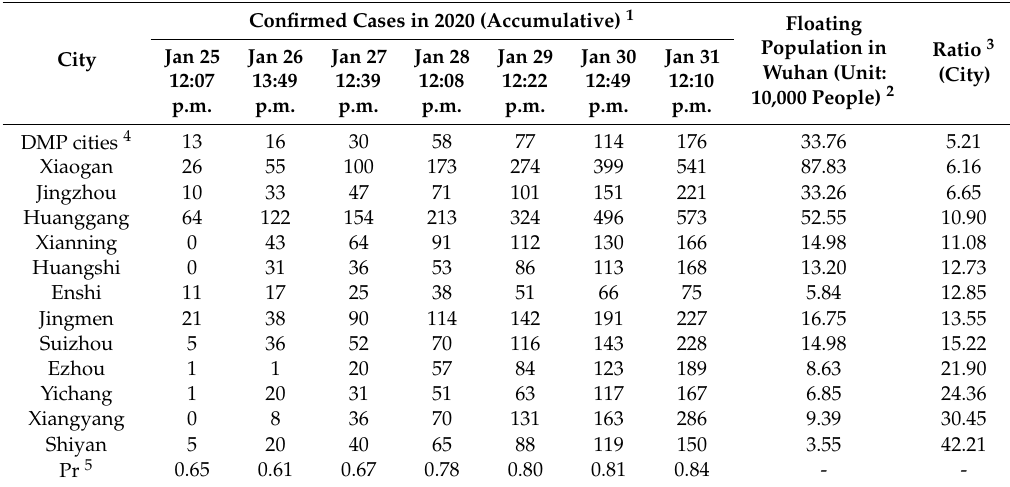
Table 9. 2019-nCoV confirmed cases and floating population from Wuhan in Hubei Province.